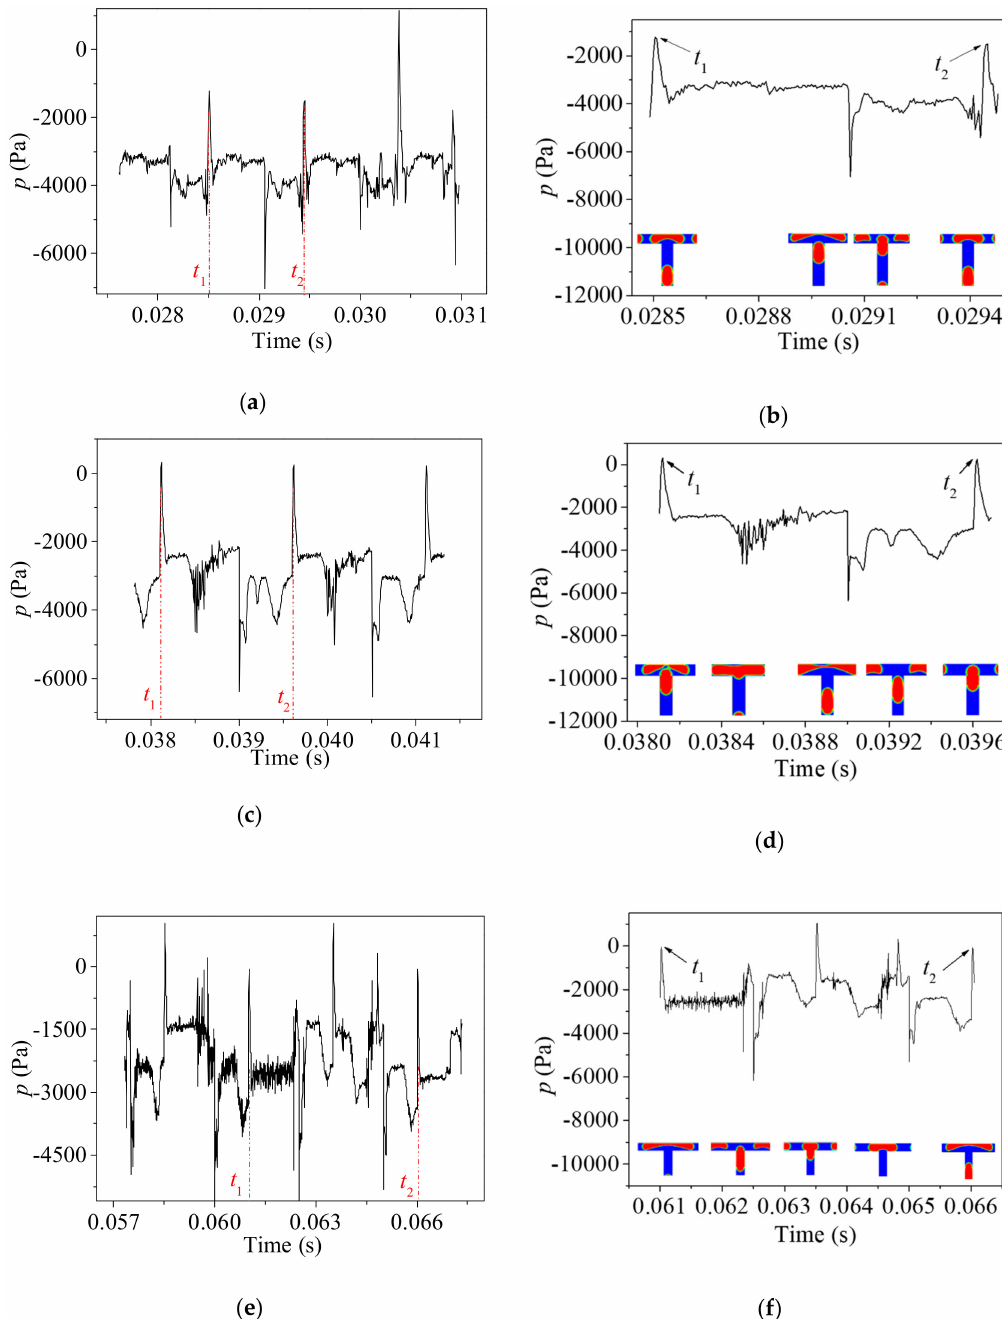
Figure 6. Pressure variation at the center of the second bifurcation. ( a , b ): Ca 0 = 0.0111; ( c , d ): Ca 0 = 0.00694; ( e , f ): Ca 0 = 0.00416. (Pressure variation during the selected time period from the left column are shown in the right column. t 1 and t 2 are the beginning and end of the selected time period, respectively as the arrows pointed in the right